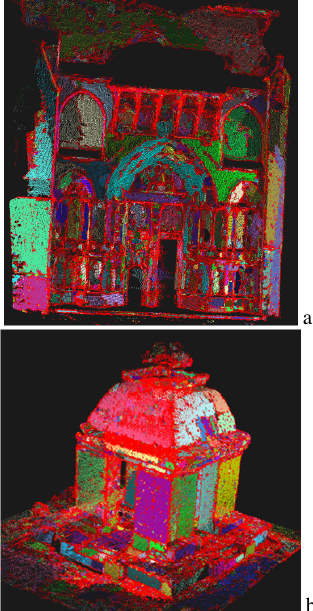
Figure 6. The region-growing algorithm applied to the S. Emilion portal (a) and to the Prasat in Angkor (b)